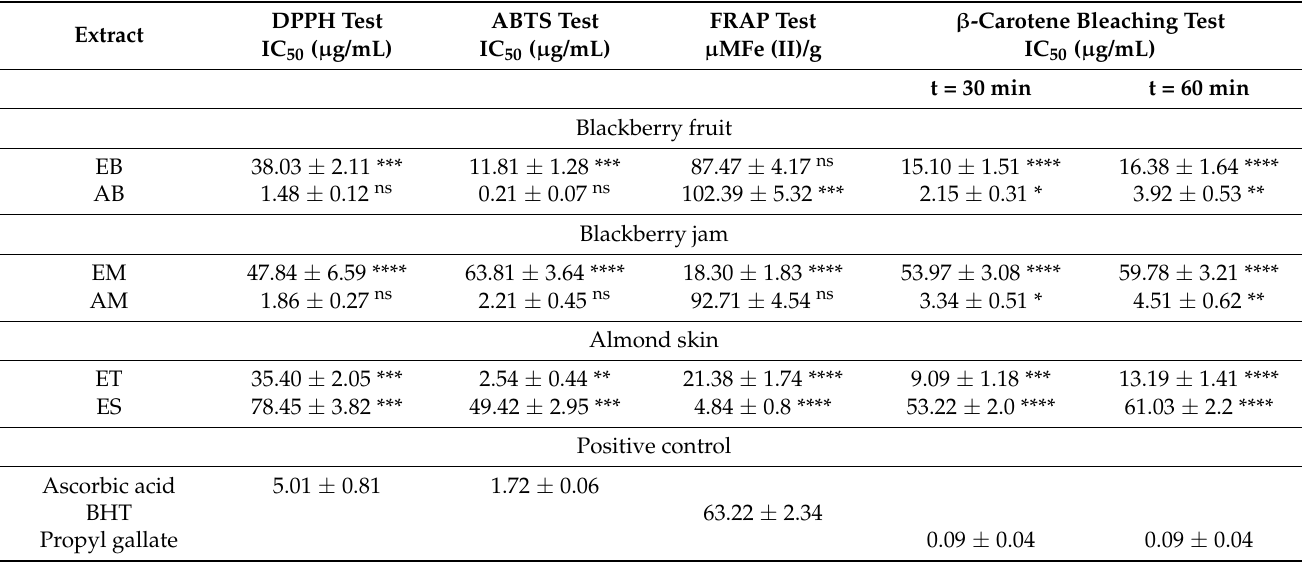
Table 5. Antioxidant activity of investigated